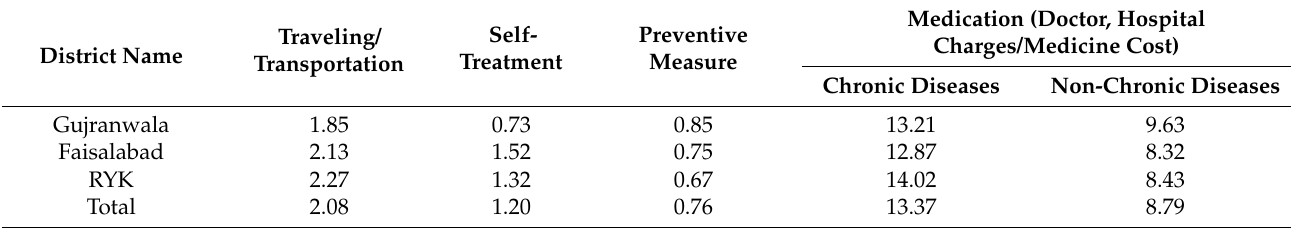
Table 5. Health costs incurred caused by crop residue burning